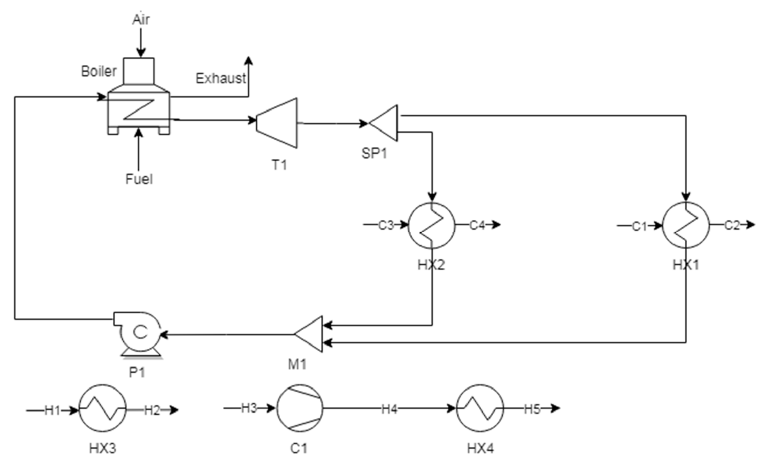
Figure 6. Steps of the sources/sinks identification unit.